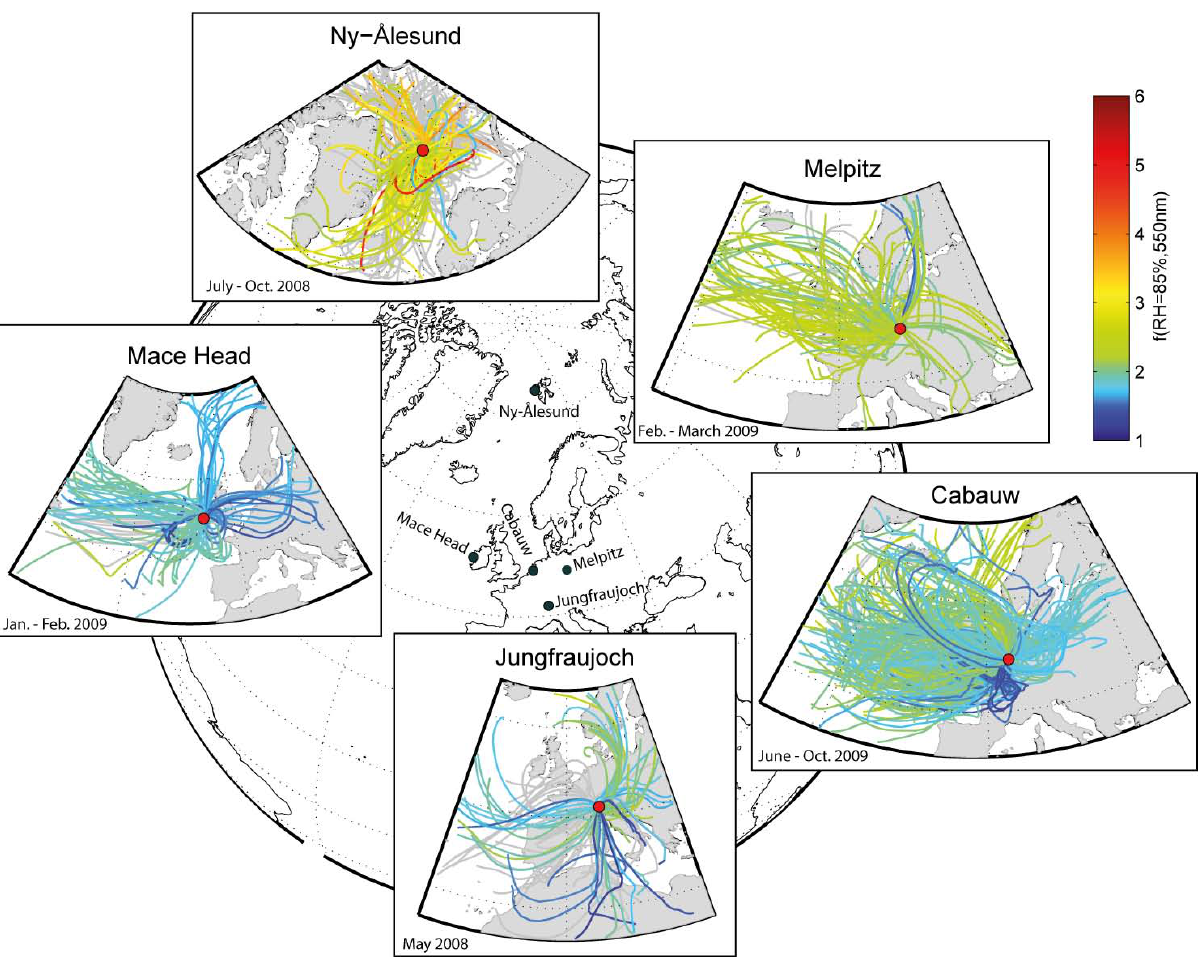
Fig. 3. 72h air mass back trajectories (FLEXTRA) color-coded by the f (RH = 85%, 550nm) measured at the time the air parcel arrived at the